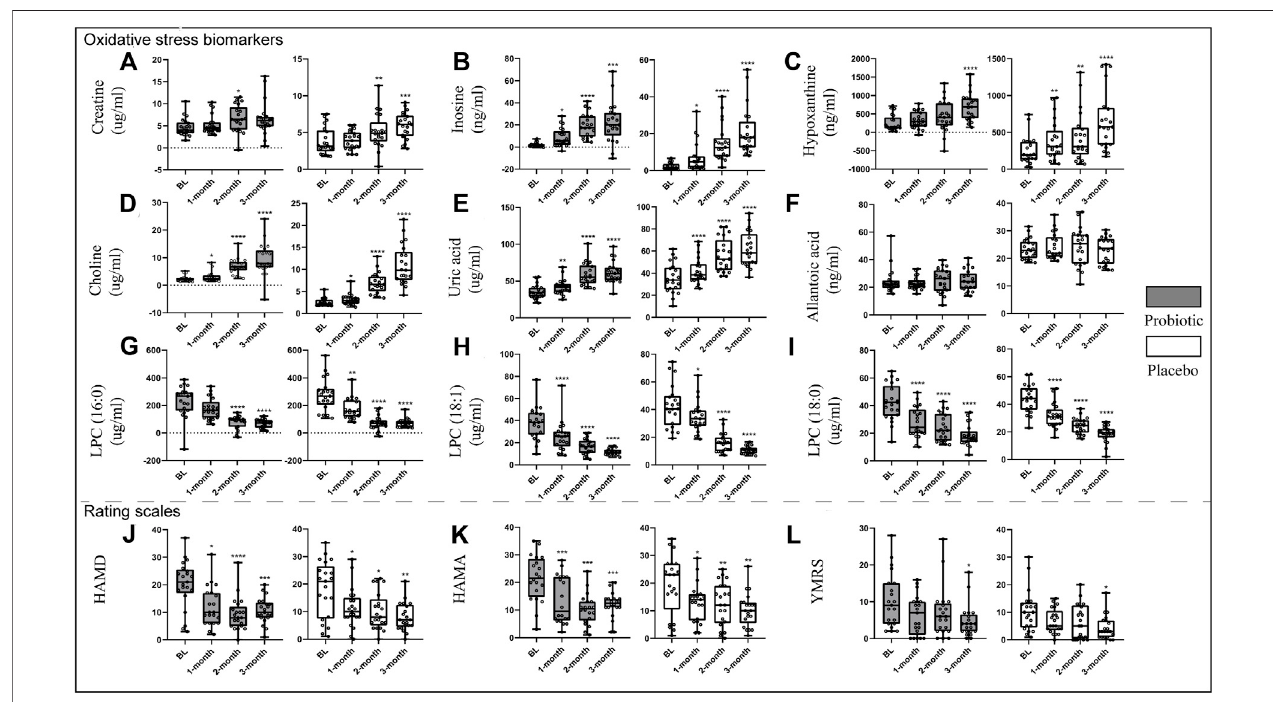
FIGURE2| Changesinoxidativestress-relatedbiomarkers[ (A) ,creatine; (B) ,inosine; (C) ,hypoxanthine; (D) ,choline; (E) ,uricacid; (F) ,allantoicacid; (G) ,LPC(16: 0); (H) , LPC (18:1); (I) , LPC (18:0)] and scales [ (J) , HAMD; (K) , HAMA; (L) , YMRS] after treatment in both groups. * p < 0.05, ** p < 0.01, *** p < 0.001, **** p < 0.0001.